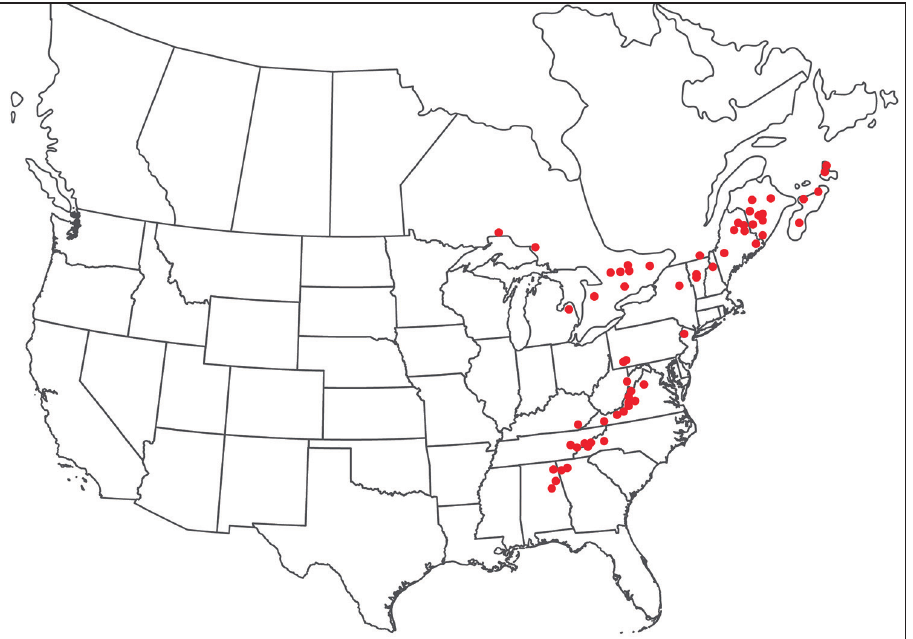
Figure 164. Torrenticola nigroalba